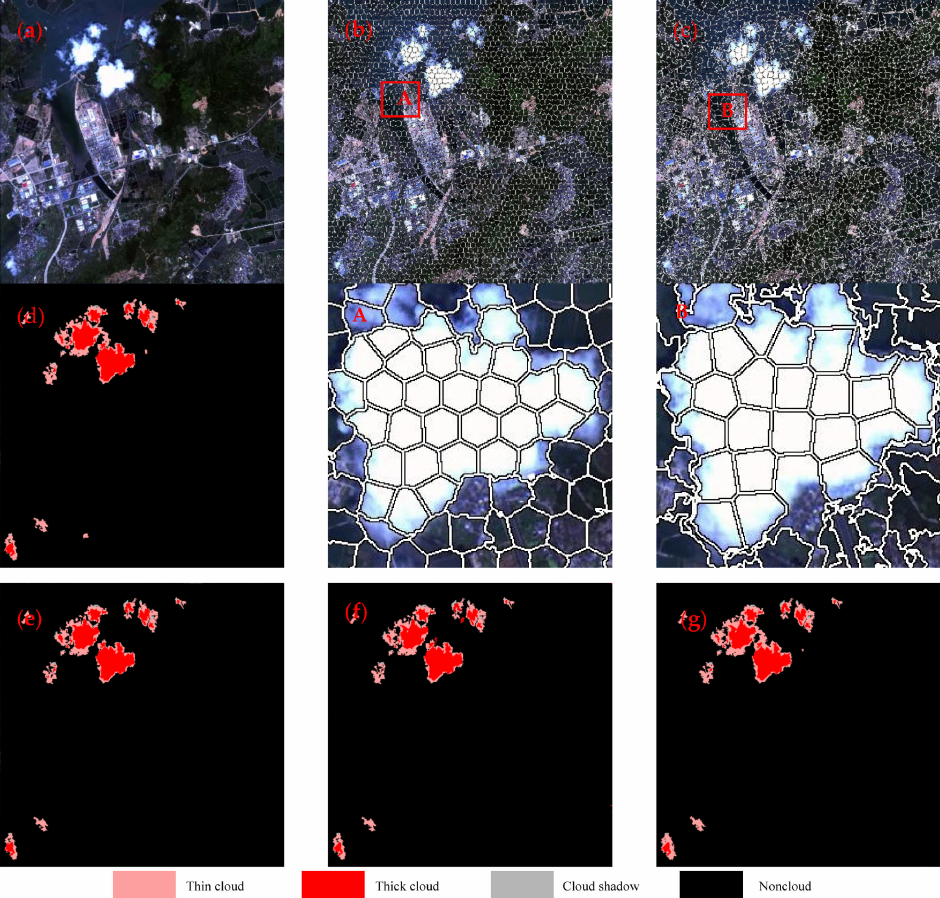
Figure 8. Multilevel cloud detection results using different superpixel segmentation methods: ( a – c ) Original image, A-SLIC segmentation map, and SLIC segmentation map, respectively; A and B are the magnified area corresponding to the red line regions of the segmentation map. ( d – g ) Ground truth reference, A-SLIC + MCNNs, SLIC + MCNNs, and Pixel + MCNNs, respectively.